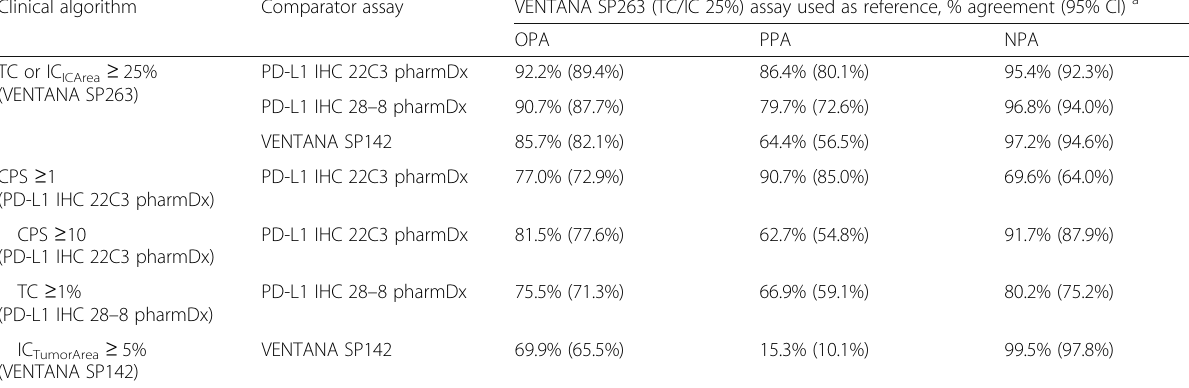
Table 2 OPA, PPA, and NPA between PD-L1 assays Clinical